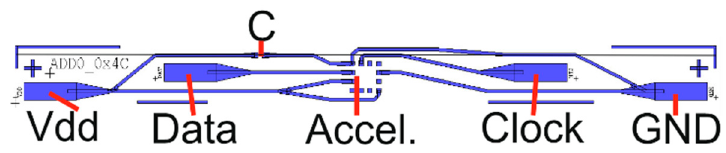
Figure 1. Flexible strip circuit top view with MC6470, 4 external connection pads (Vdd, Data, Clock and GND) and de-coupling capacitor (C). Overall strip dimensions: 40 mm long × 3.3 mm wide.